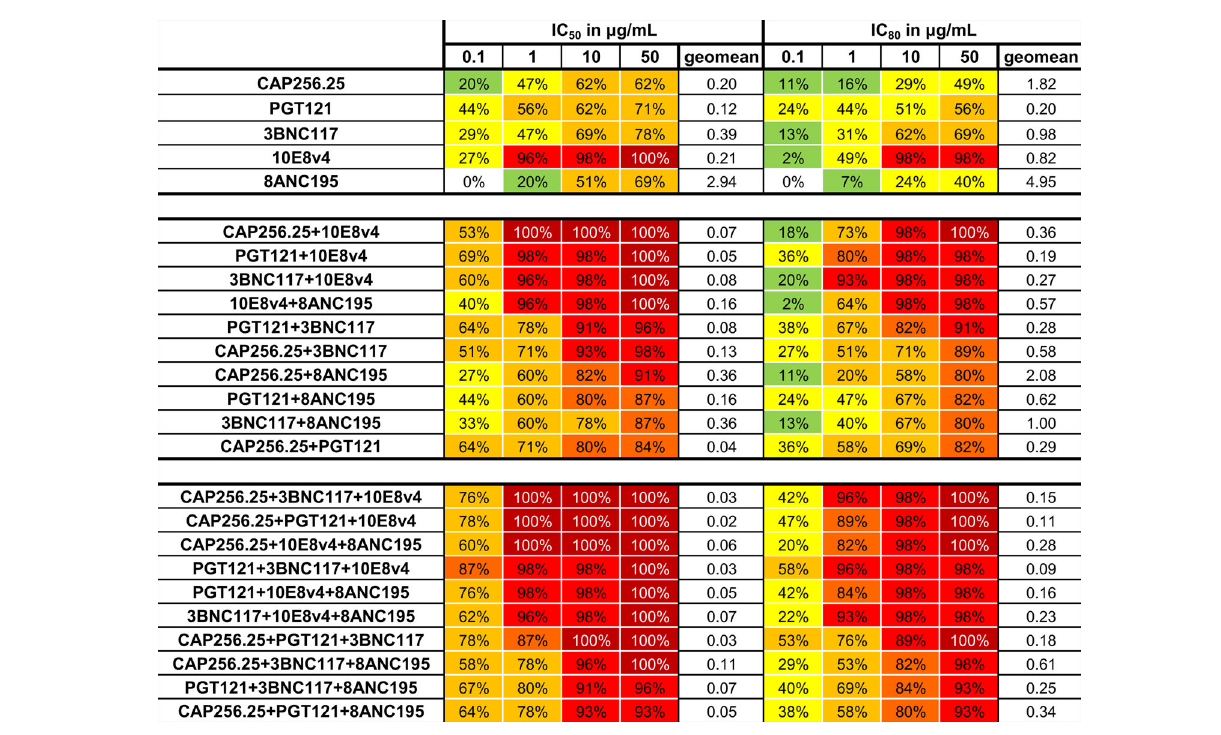
FIGURE 6 | Neutralization breadth for single and combinations of scFv against a 45-virus panel at four concentrations. Percentage neutralization at 0.1, 1, 10, and 50 m g/mL was calculated from single scFv titers and from predicted scFv dual and triple combination titers for the IC 50 and IC 80 . Colors indicate percentage neutralization with 1-19% in green, 20-49% yellow, 50-79% yellow-orange, 80-89% orange, 90-99% red and 100% dark red. Geometric mean at 50 m g/mL is also given. Each scFv is present in the combinations at the titers